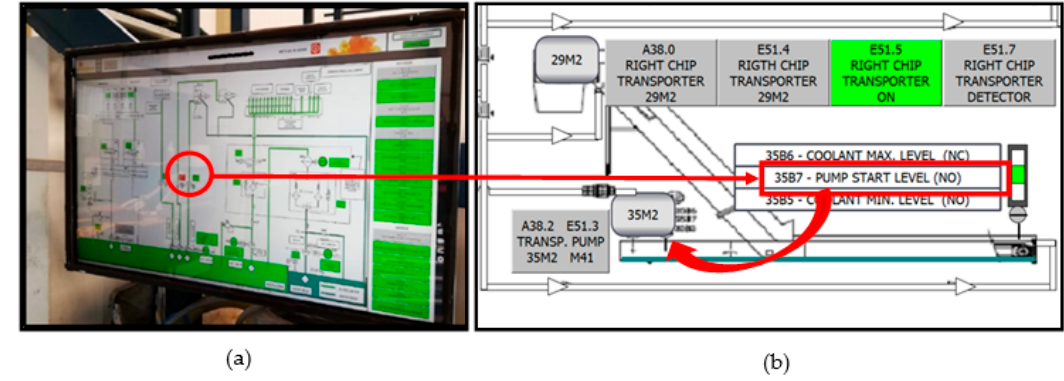
Figure 1. ( a ) Supervisory control and data acquisition (SCADA) system; ( b ) retrofitting scheme as SCADA screen for locating a specific system fault.